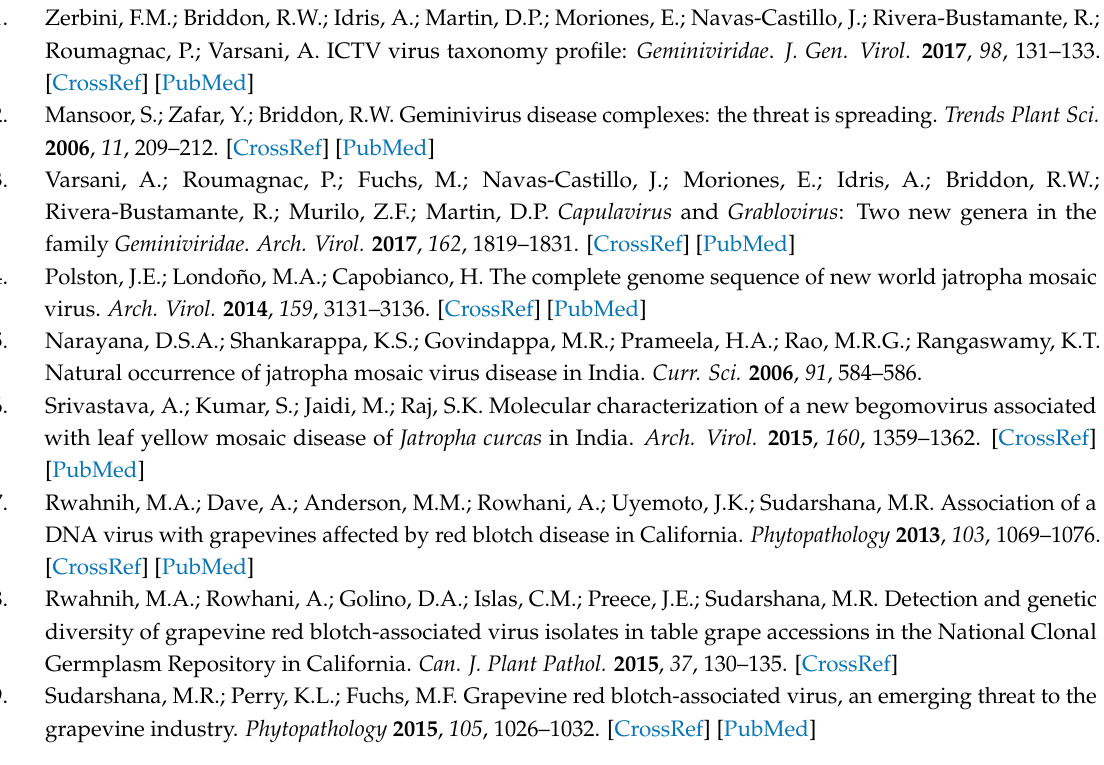
Table S1: Primers used for PCR amplification and probe